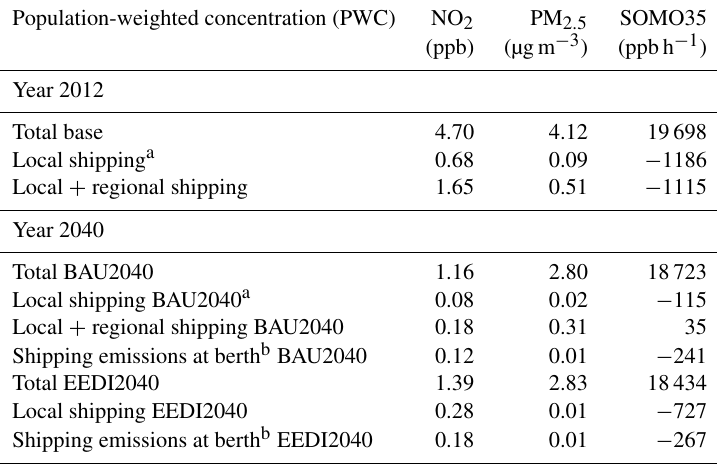
Table 3. Population-weighted exposure in the Gothenburg area to NO 2 (in ppb), PM 2 . 5 (in µgm − 3 ), and ozone (as sum of hourly means over 35ppb) in 2012 and in the BAU2040 and EEDI2040 scenarios. The exposure caused by local shipping, local and regional shipping, and ships at berth is given